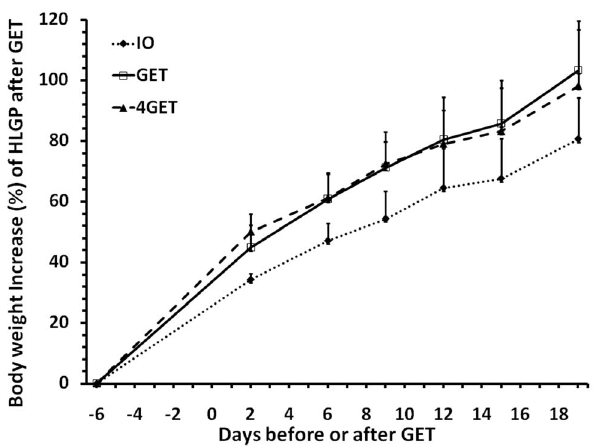
Figure 4. Body weight increase of HLGP after i.d. DNA injection and non-invasive GET. Delivery group, IO: 50 m L DNA without pulse delivery; GET: 50 m L DNA with 1 pulse delivery on the injection site; 4GET: 4 injections with 50 m L DNA and each pulse delivery on the injection site. Bars represent mean 6 SD. 4 animals were analyzed for each delivery group. * p , 0.05 for 4GET or GET vs IO by One Way RM-